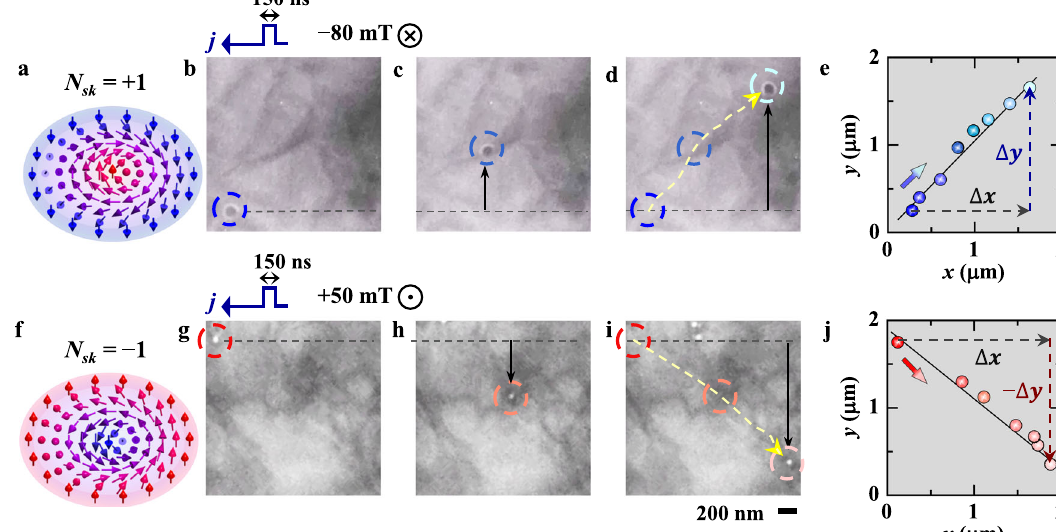
Fig. 3 Reversal of Hall motion for the single skyrmion with an opposite topological number. a , f Schematics of skyrmions with the topological number N sk of + 1 ( a ) and − 1 ( f ). b – d , g – i Over-focus L-TEM images showing the reversal of Hall-motion direction at RT: b – d for the N sk = + 1 skyrmion at − 80 mT (as denoted by (cid:4) ) and at j = − 5.05 × 10 10 A m − 2 and g – i for the N sk = − 1 skyrmion at + 50 mT (as denoted by (cid:5) ) and at j = − 4.82 × 10 10 A m − 2 . The pulsed current fl ows from right to left as marked by the arrows above ( b ) and ( g ). The dashed circles mark the skyrmion positions with the arrows in ( d ) and ( i ) indicating the direction of the trajectory. e , j Summary of the skyrmion traces, with the straight lines showing the translational displacement ( 4 x ) and the reversed vertical displacements ( 4 y in ( e ) and (cid:3)4 y in ( j